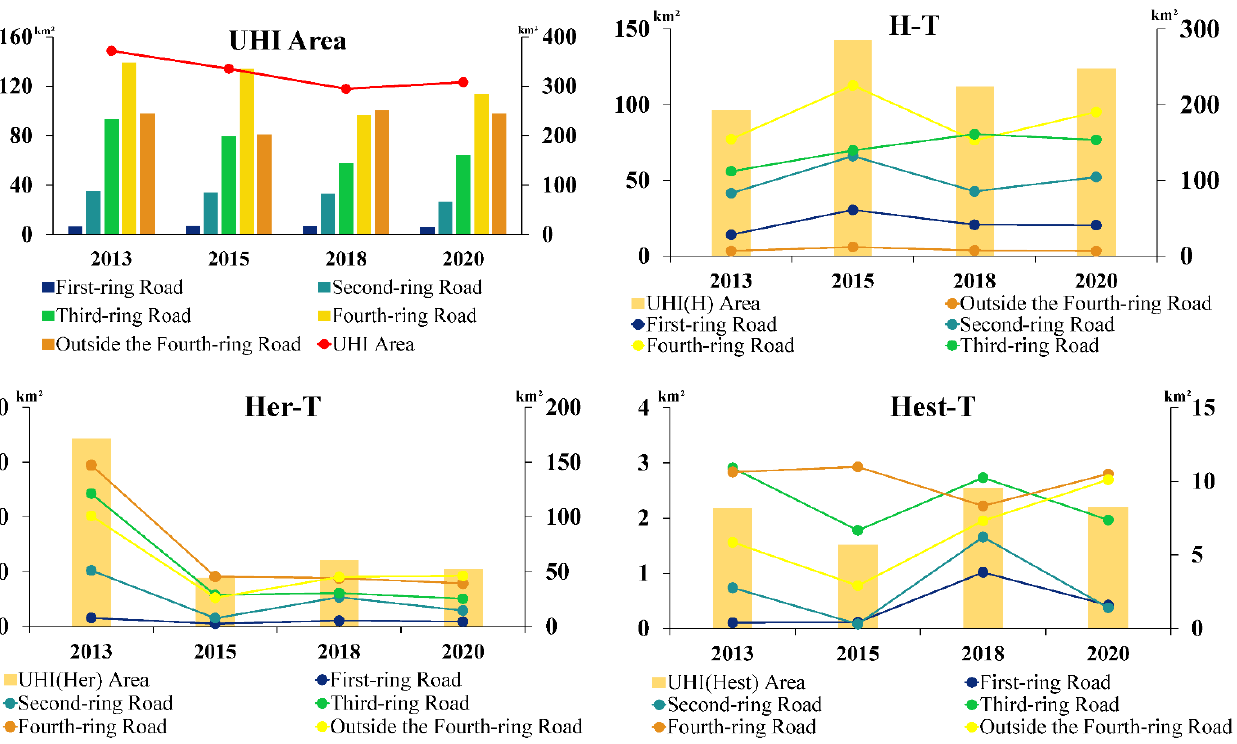
Figure 6. The change of the heat island area during 2013 – 2020, and the annual change of the area of H-T, Her-T, and Hest-T in each ring road.